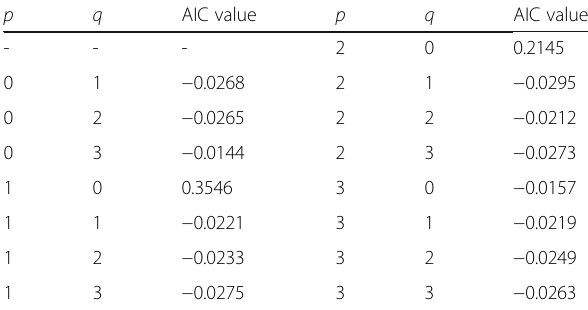
Table 1 AIC values of ARMA model of power